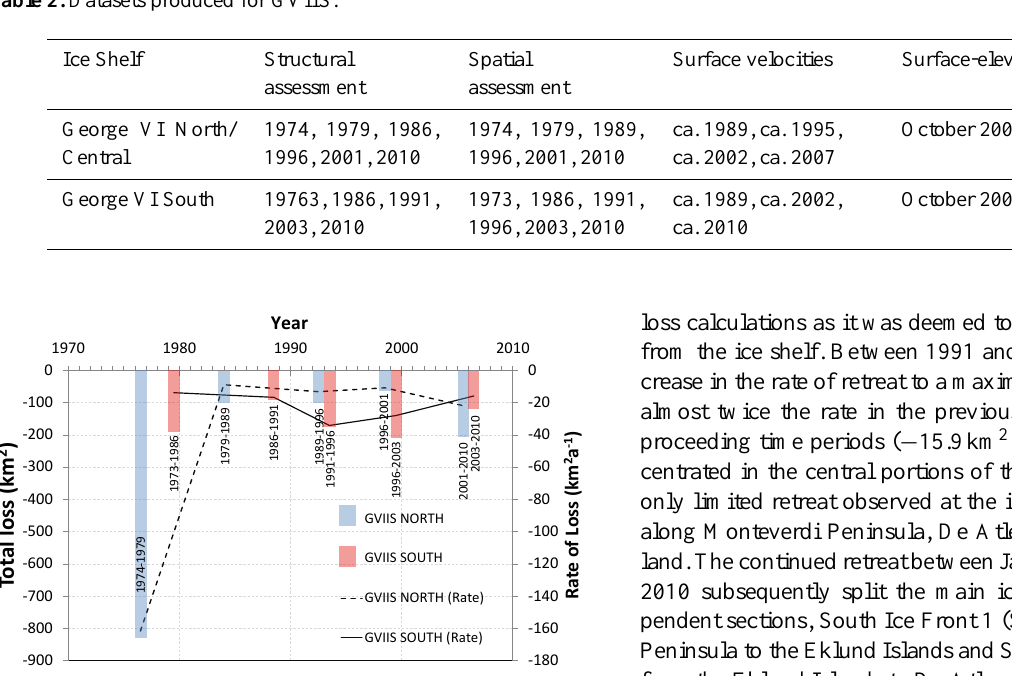
Table 2. Datasets produced for GVIIS.